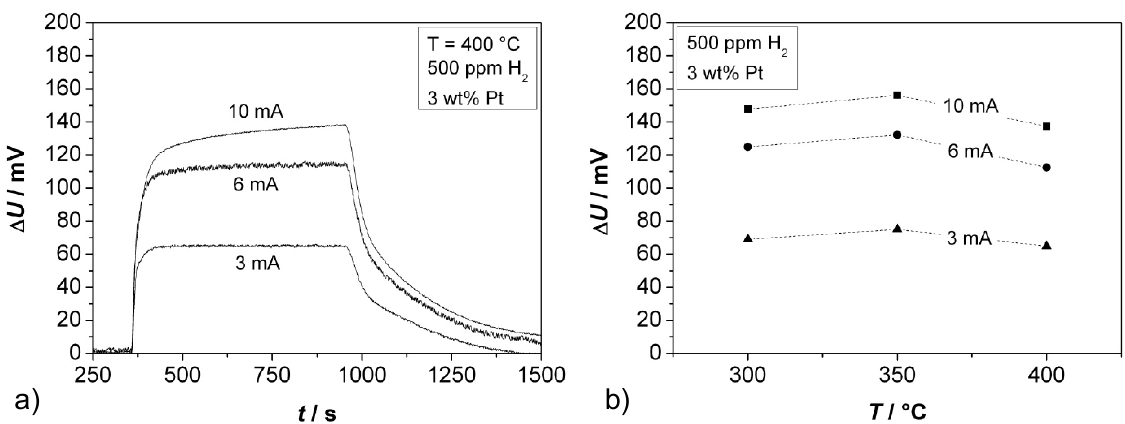
to the base gas at 400 °C; 2 O film 2 3